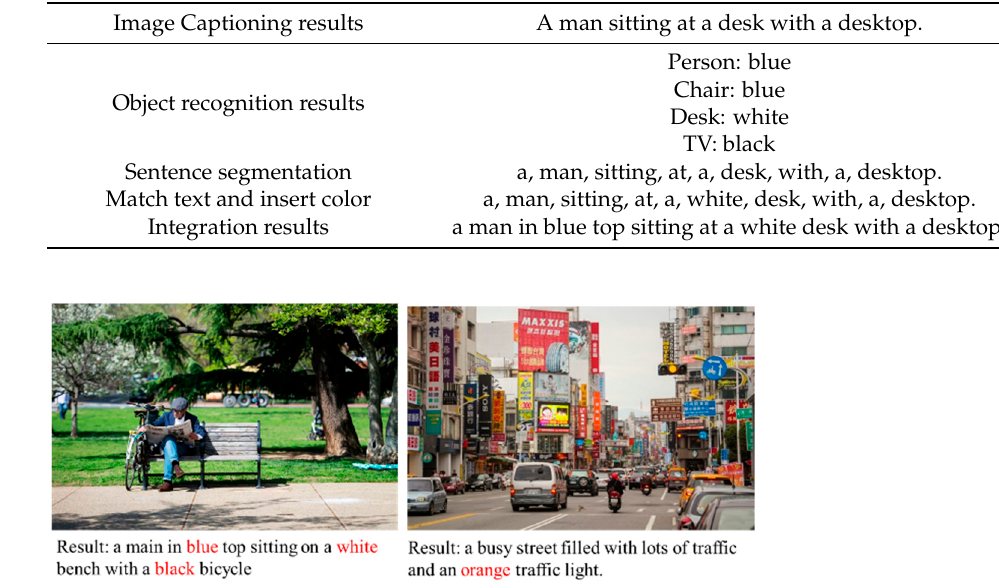
Figure 17. Misjudgment of the image captioning algorithm. Figure 18. Extraction of the object outlined in a rectangle shape. Figure 19. The integrated result of the enhanced image captioning.